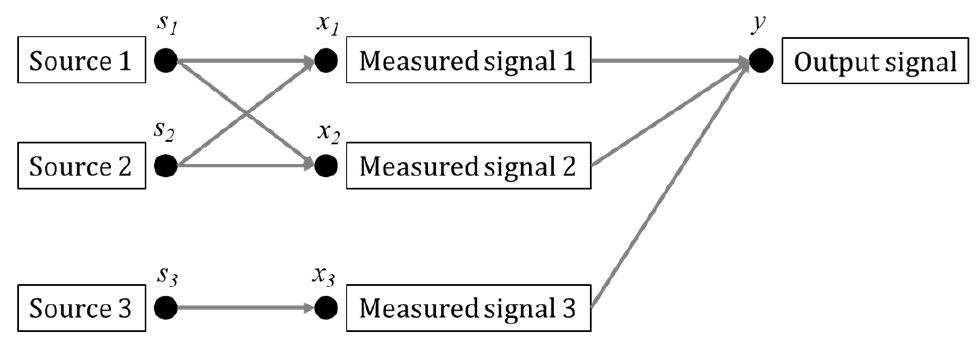
Figure 3. Numerical simulation model.